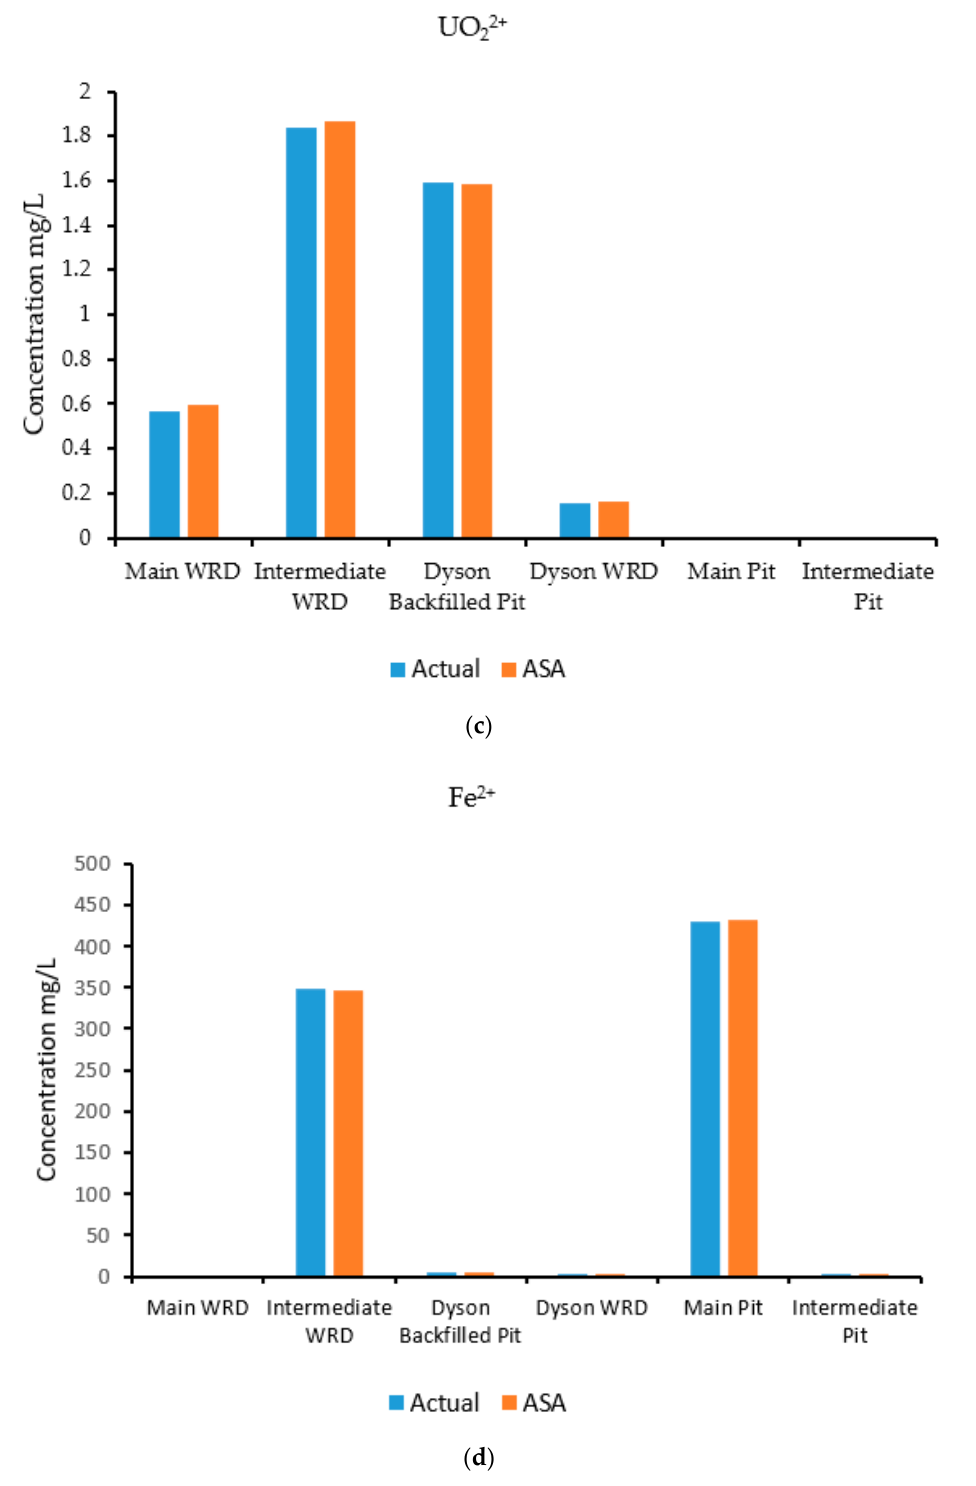
Figure 8. ( a ) Comparison of Cu 2+ species concentrations (mg/L) estimated by the ASA-linked optimization model and actual data. ( b ) Comparison of SO 42 species concentrations (mg/L) from the ASA-linked optimization model and synthetic data. ( c ) Comparison of UO 22+ species concentrations (mg/L) from the ASA-linked optimization model and actual data. ( d ) Comparison of Fe 2+ species concentrations (mg/L) from the ASA-linked optimization model and the actual data.